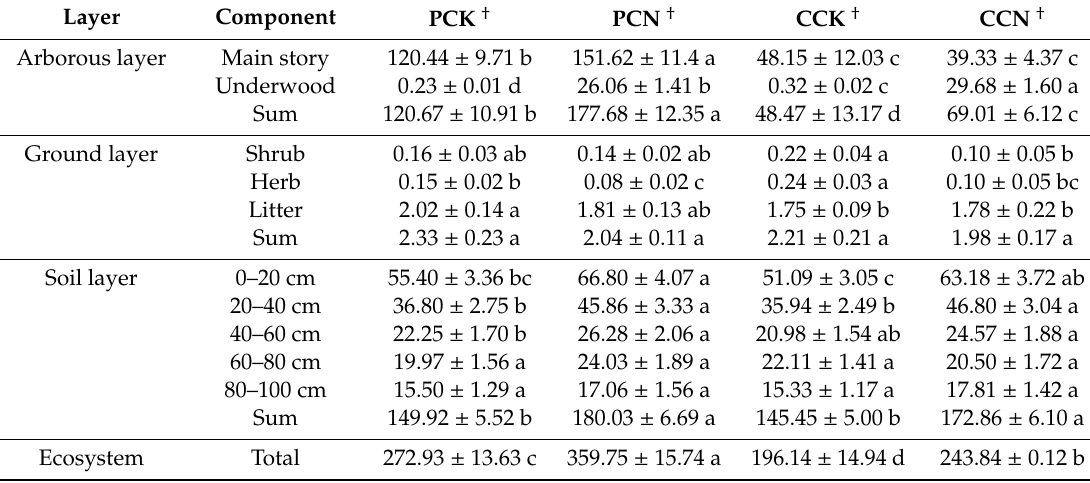
Table 5. C stock of the di ff erent components in the four plantation ecosystems (mean ± standard error, n = 4, t · ha − 1